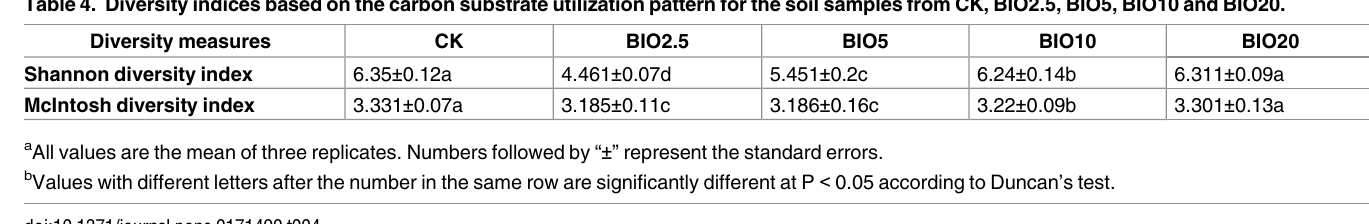
Table 4. Diversity indices based on the carbon substrate utilization pattern for the soil samples from CK, BIO2.5, BIO5, BIO10 and BIO20. Diversity measures